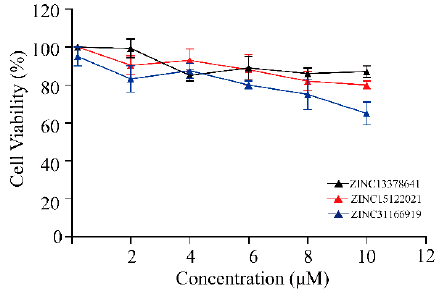
Figure 5. Cell viability of normal breast cells treated with three potential HER2 inhibitors by using CCK-8 assay. Error bars correspond to standard deviations from three independent measurements.